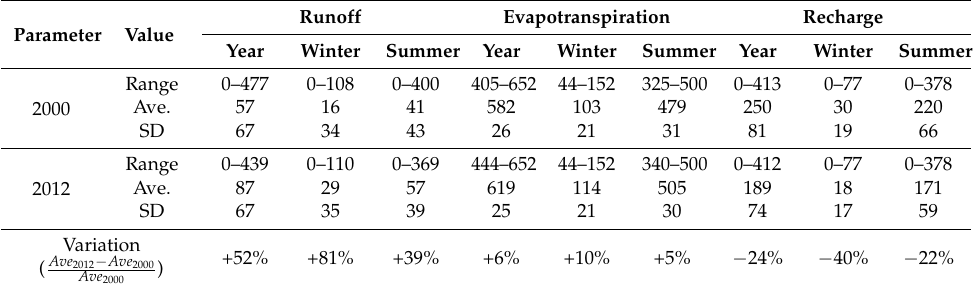
Table 5. Seasonal and annual water balance components in urban region of Beijing from 2000 to 2012. Parameter